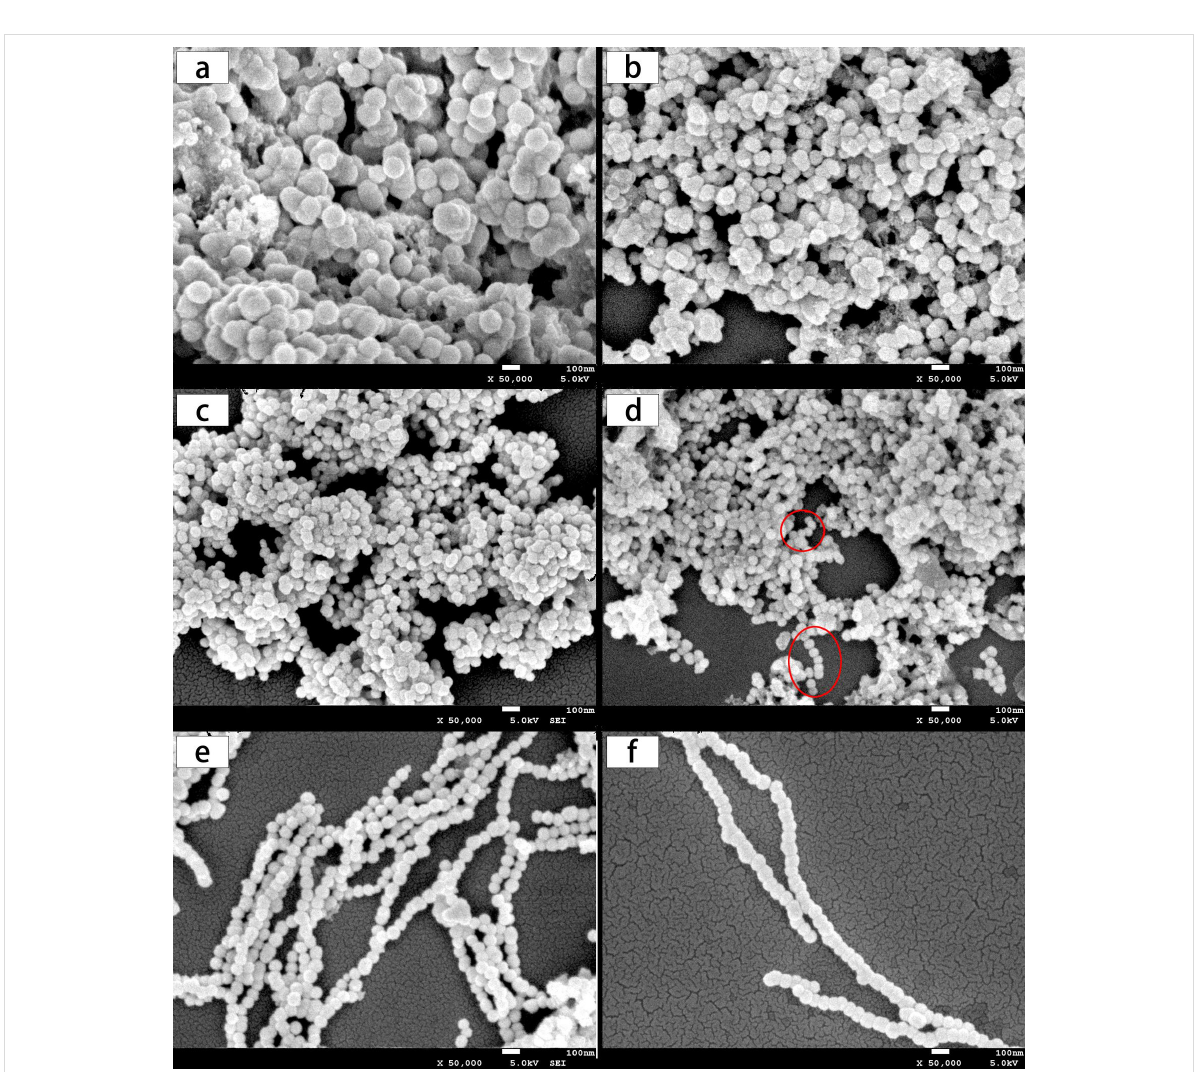
Figure 3: SEM micrographs of products prepared after the reaction proceeded for 30 s (a), 60 s (b), 120 s (c), 240 s (d), 300 s (e), and 600 s (f).